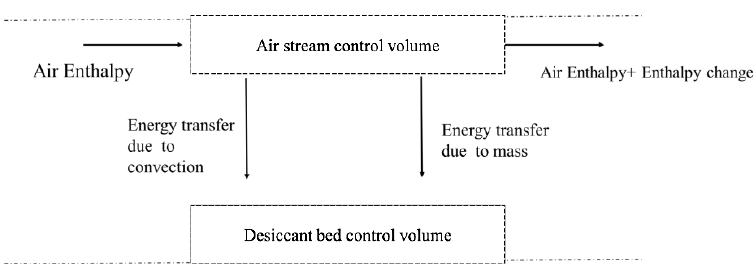
Figure 7. Schematic representation of energy balance for a control volume.